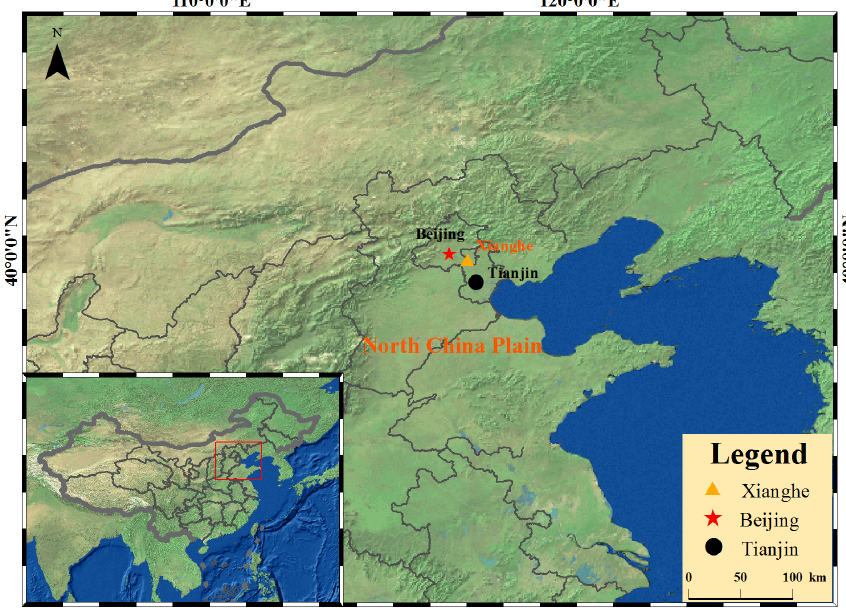
Figure 1. Map showing the Xianghe sampling site and surrounding areas. The map was drawn using ArcGIS software. The base map is the World Topographic Map from ©ESRI (Environmental Systems Research Institute, Inc.) (https://www.arcgis.com/home/item.html?id= 30e5fe3149c34df1ba922e6f5bbf808f, last access: September